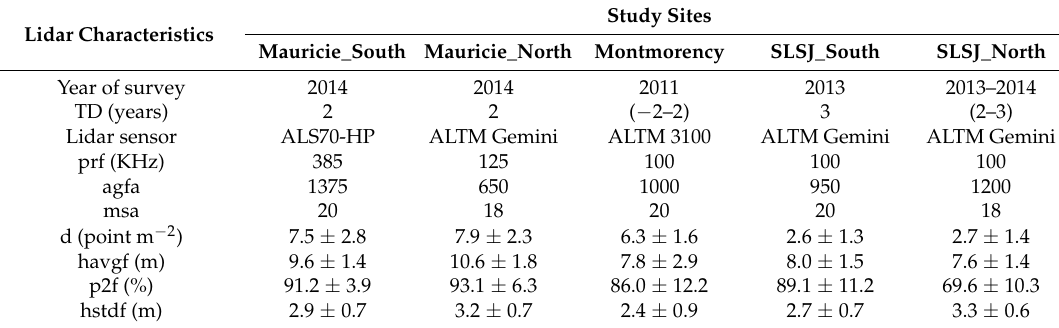
Table 2. Summary of the lidar data a